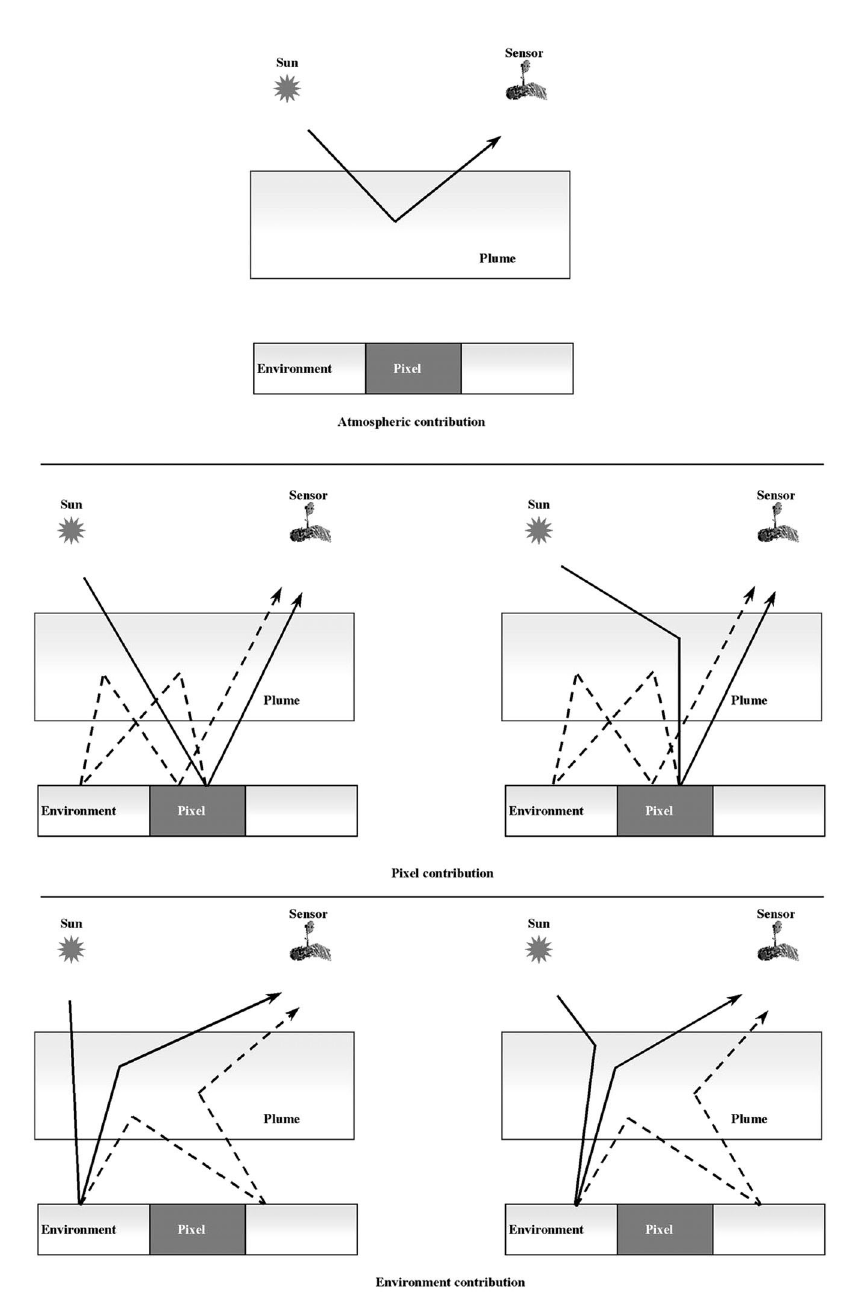
Fig. 3. Scheme of different solar radiation pathways measured by a remote sensing